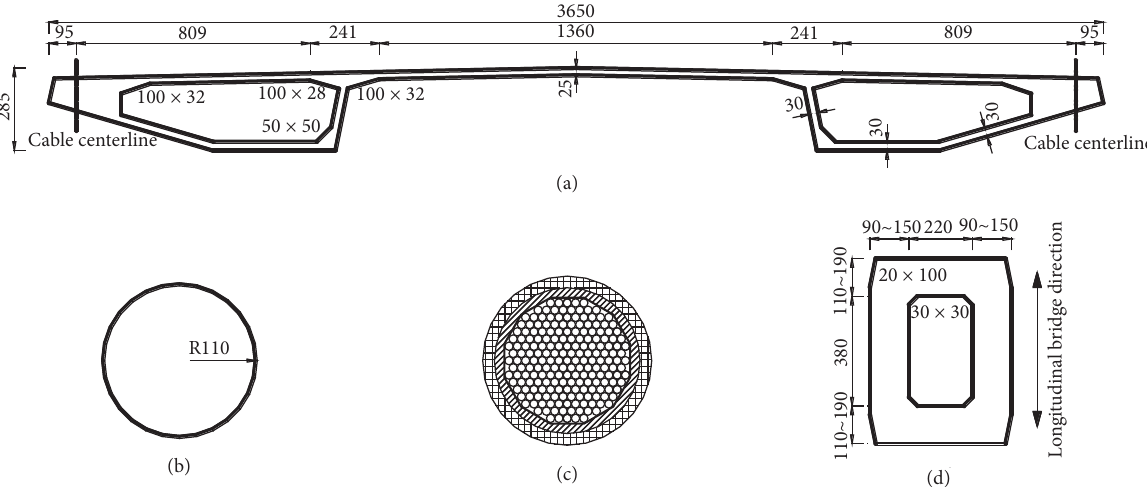
Figure 3: Cross sections of main stress components (cm). (a) Girder. (b) Pile foundation. (c) Stay cable of parallel wires. (d) Tower (top ∼